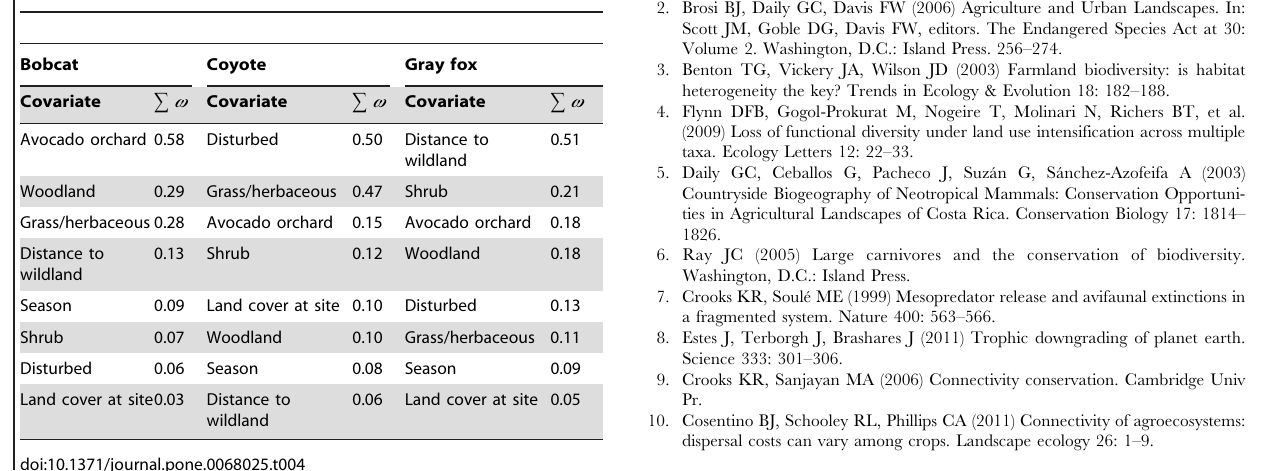
Table 4. Variable importance weights ( v ) for predictors of occupancy for bobcats, coyotes, and gray foxes.